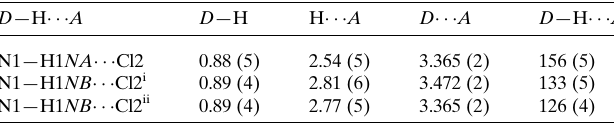
Table 1 Hydrogen-bond geometry (A˚ , (cid:5) ).